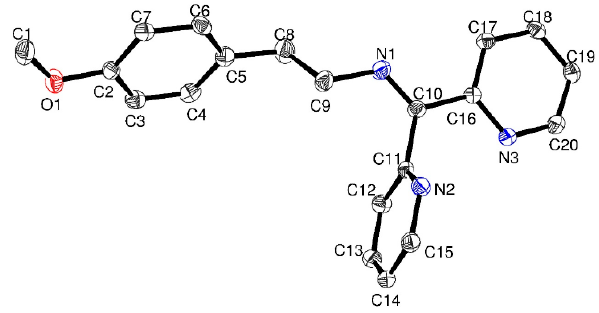
Figure 5. Crystal structure of compound 3a .